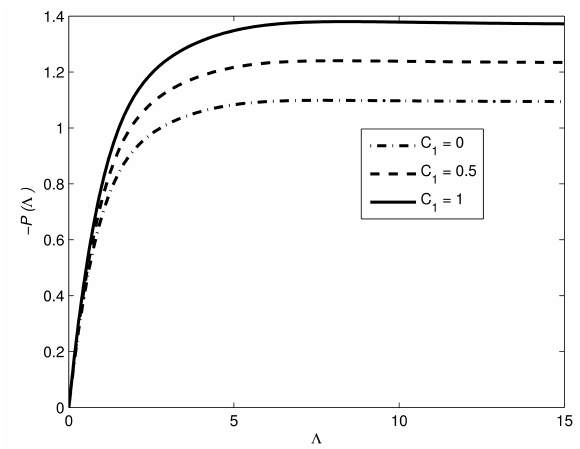
Figure 8: Effect of η on F ( Λ ) keeping ζ = 0.2 , C 1 = C 2 = C 3 = 20 , Pr = 6.8 , Br = 1 and Re = 2950